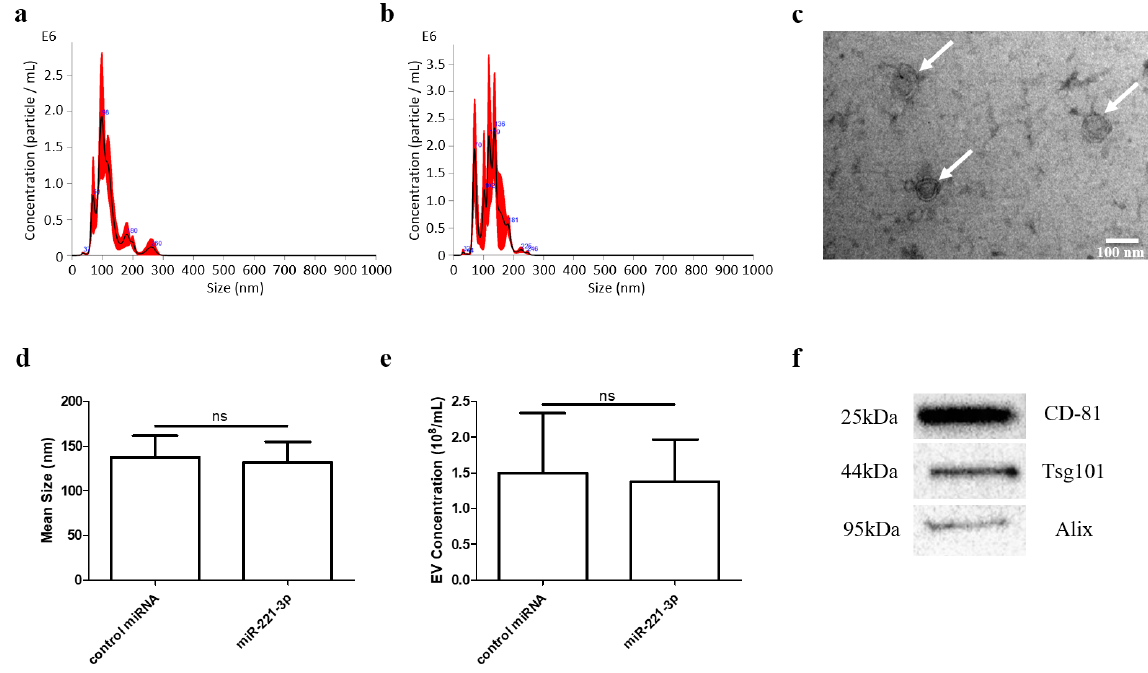
Figure 1. EVs were isolated by ultracentrifugation and identified by NTA, TEM and Western blotting. Particle size distribution of scramble miRNA-loaded ( a ) and miRNA-221-3p-loaded EVs ( b ) isolated by ultracentrifugation was determined by nanoparticle tracking analysis (NTA). Typical morphology ( white arrows) of EVs was observed under TEM ( c ) scale bar 100 nm. Transfection of miRNA-221-3p did not affect average size ( d ) and concentration ( e ) of EVs compared to control RNA transfections. Exosome-specific protein markers CD81, TSG101 and Alix were detected by Western blotting ( f ). ns stands for not statistically significant.